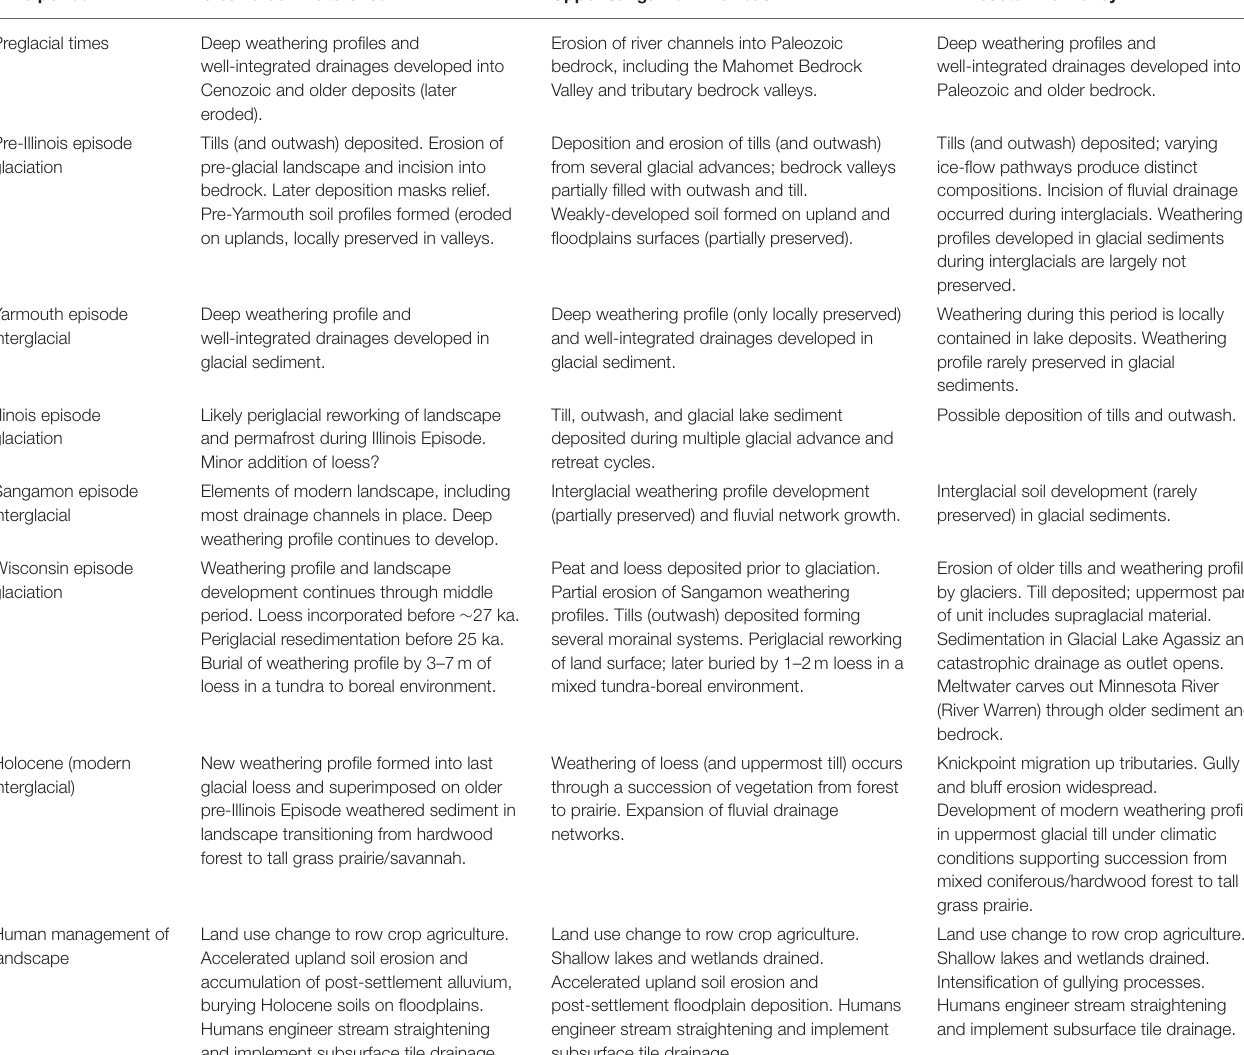
TABLE 1 | Summary of events shaping the CZ at the IML-CZO